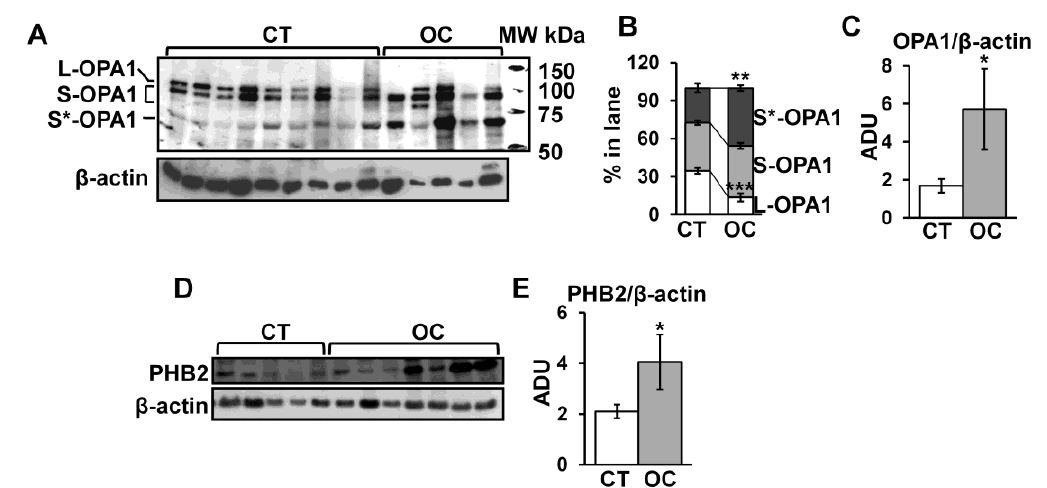
Figure 2. Optic atrophy 1 protein (OPA1) and prohibitin 2 (PHB2) protein levels in CT and OC tissues. The sample tissues of CT and OC were homogenized in bu ff er A (see Section 4) and centrifuged at 600 × g ; the resulting supernatant was sonicated and utilized for Western blotting analysis. ( A , D ) Representative images of Western blotting analysis. Proteins from CT and OC samples were loaded on 8% SDS-polyacrylamide gel electrophoresis (PAGE). After separation, the proteins were transferred on nitrocellulose membranes and immunoblotted with the antibodies against OPA1 and PHB2. Protein loading was assessed with β -actin antibody. The immunoblotting against β -actin antibody in panel D is the same shown in Figure 3D, belonging to the same experiment series. ( B ) The histograms represent the percentage of arbitrary densitometric units (ADU) of long (L), short (S), and S* forms of OPA1 in each lane. ( C , E ) The histograms represent the means of values of (arbitrary densitometric units) ADU ± SEM of samples. The values are means ± SEM of samples. (* p < 0.05, ** p < 0.01, *** p < 0.001, Student’s t -test). For other details, see Section 4. MW: molecular weight in kDa.